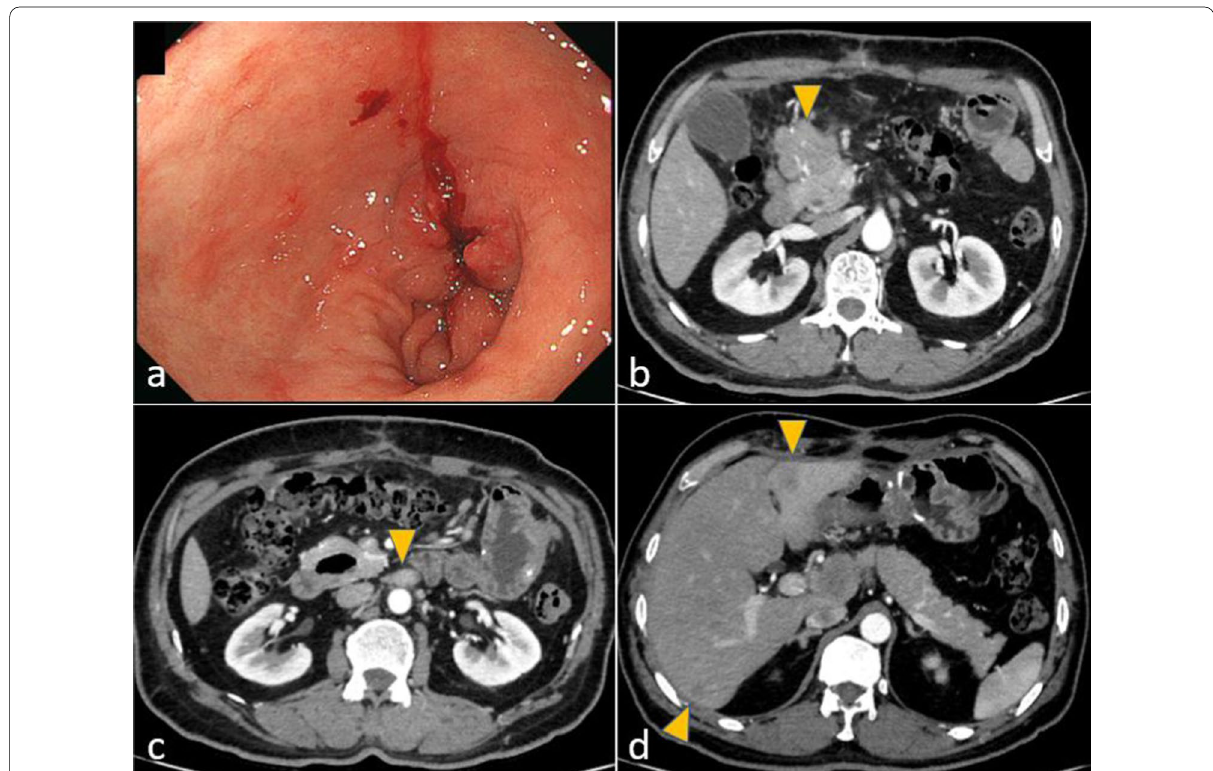
Fig. 5 Findings of case 3 with gastrointestinal endoscopy and abdominal computed tomography. a A type 3 tumor caused circular stenosis from the antrum to the pylorus. b , c Station No. 6 and 16b1 lymph nodes were enlarged. The station No. 6 lymph node had invaded the pancreatic head. d Two small liver metastases were newly found during